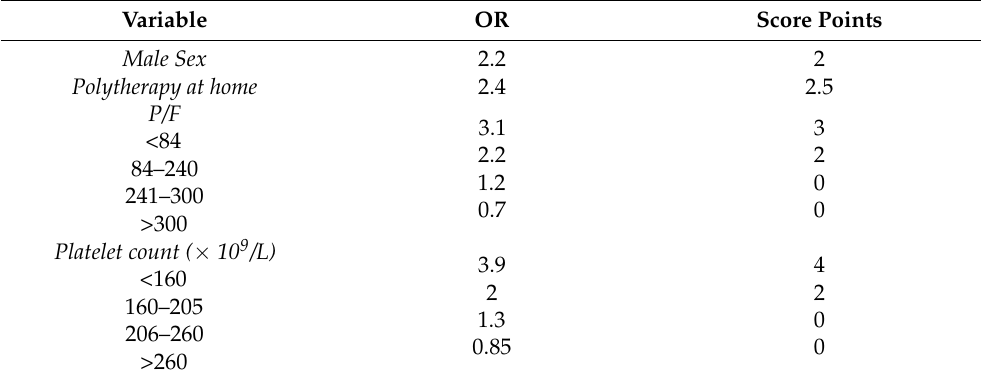
Table 5. Odds Ratios (OR) and points used to compute the hCPAP-f score.